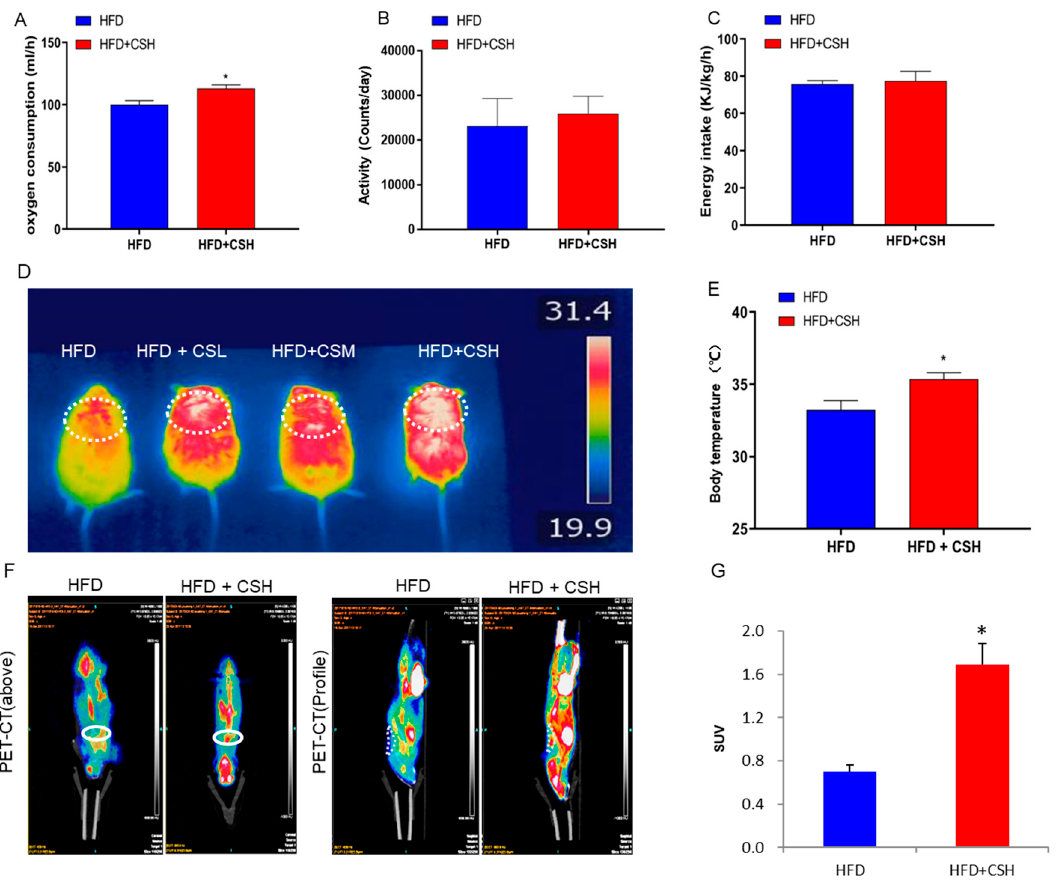
Figure 2. WECS augments whole-body energy metabolism. After 6 weeks of HFD and 7 weeks of treatment, WECS upregulated oxygen consumption ( A ). However, WECS has no effect on energy intake in mice ( B ) and activity ( C ). WECS treatment increased the thermal infrared signal ( D ) and rectal temperature ( E ) after cold stimulation of mice. PET-CT results show that WECS increased the BAT activity in mice ( F ). The bar graph represents the average uptake of 18F-FDG in BAT ( G ). Bars represent the mean + SEM, n = 3–5. * p < 0.05 compared with HFD control.